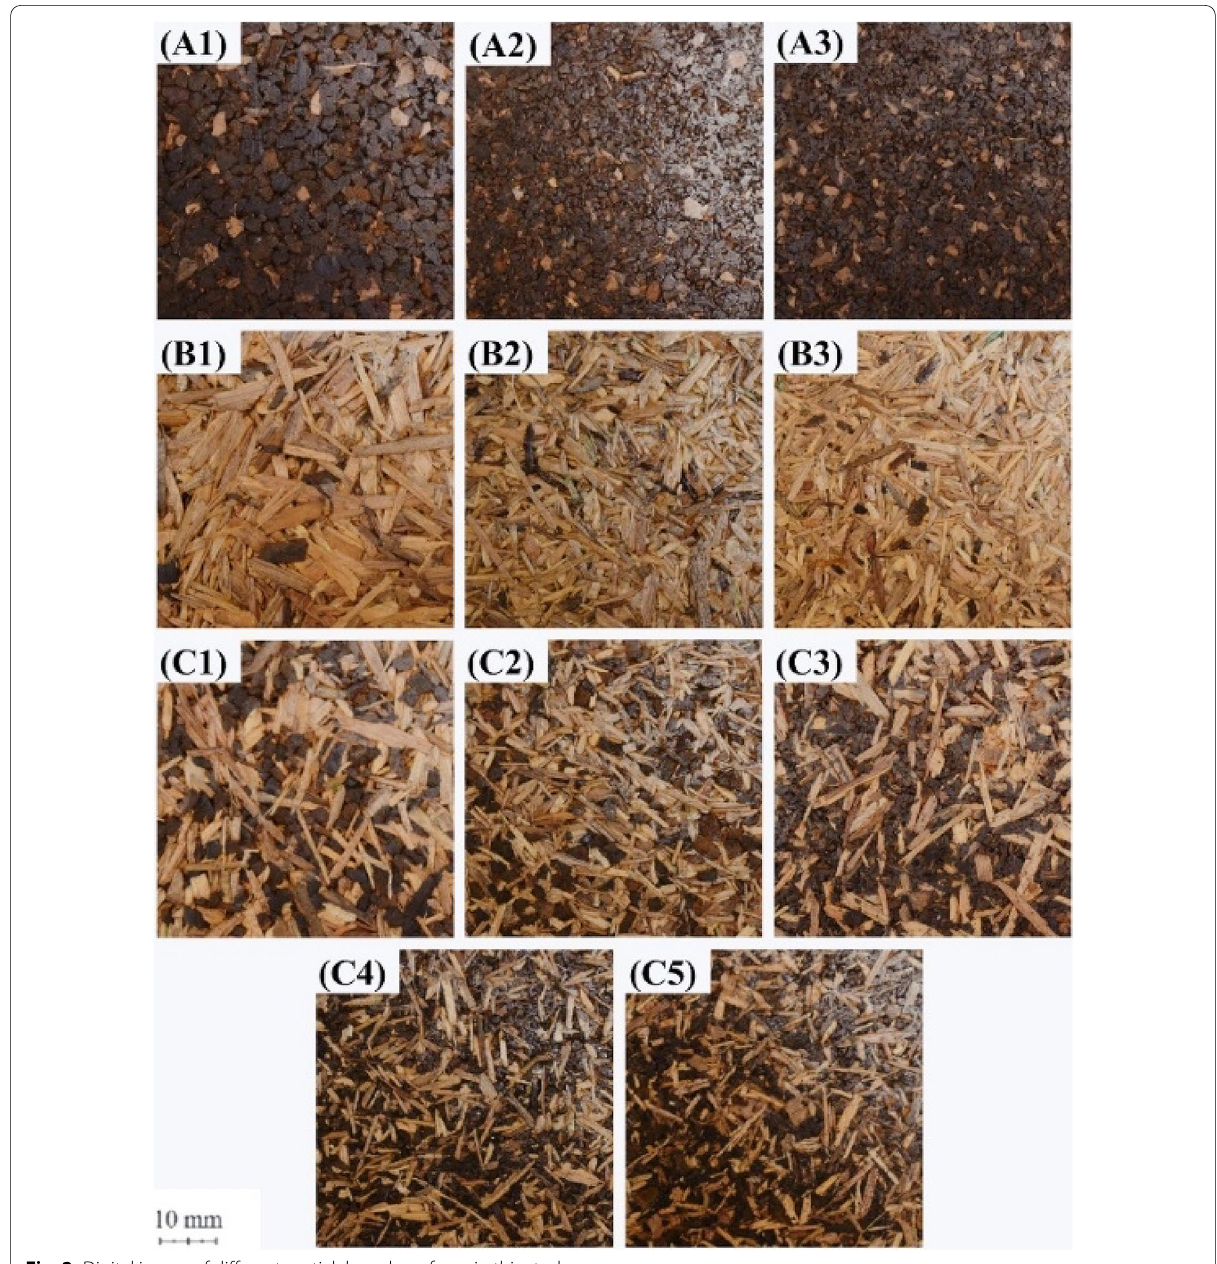
Fig. 2 Digital image of different particleboards surfaces in this